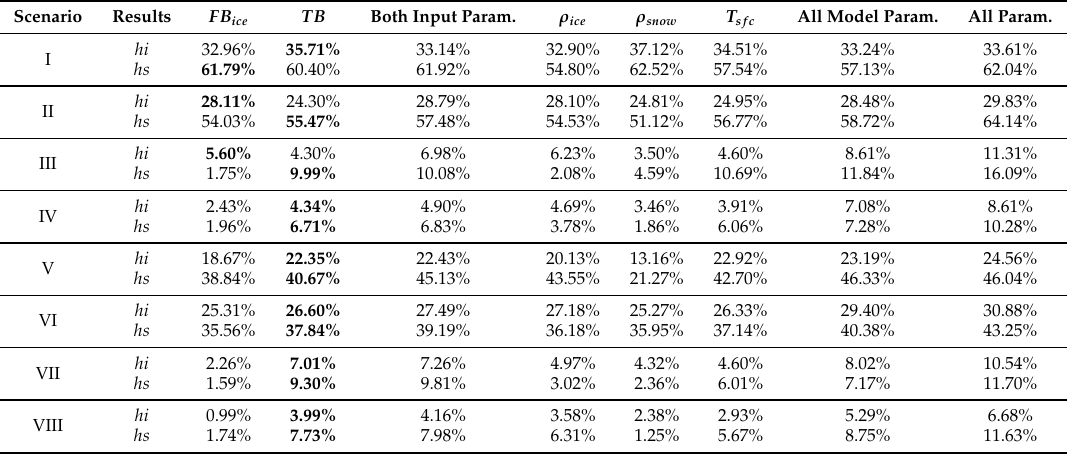
Figure 10. Same as Figure 7 but for the effect of the uncertainty in TB for the synergy of TB and FB snow . The order of subfigures are also the same as Figure 7, with ( a , b ) showing the sensitivity of the retrieved hi and hs to TB for FYI, and ( c , d ) the results for MYI. Table 6. Same as Table 4 but for the data synergy between TB and FB snow